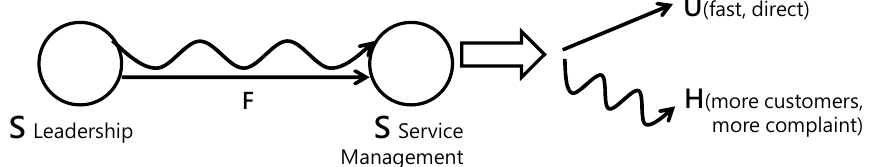
Figure 1. Su-field analysis of the relationship between leadership and service management.